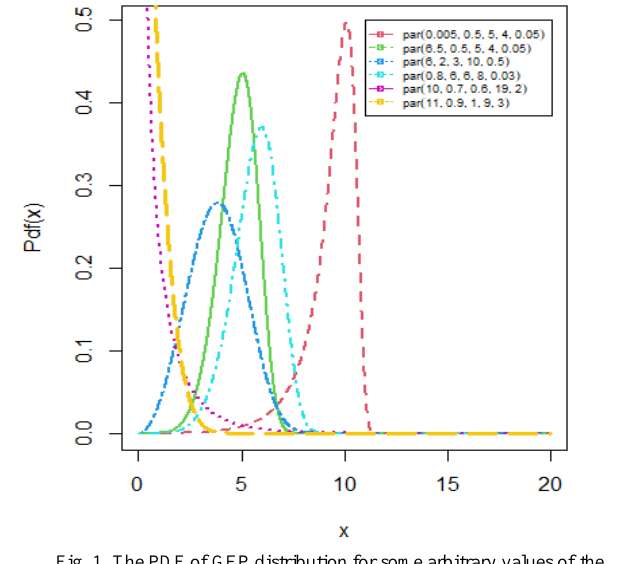
Fig. 1. The PDF of GEP distribution for some arbitrary values of the parameter